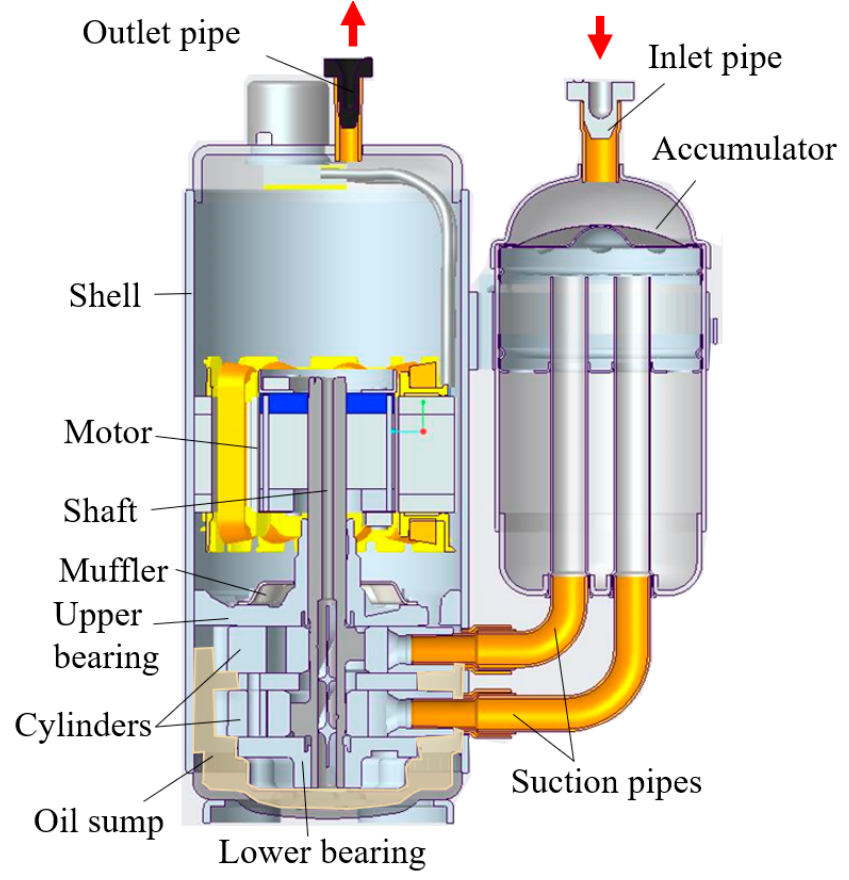
Figure 1. Schematic diagram of the rotary compressor.